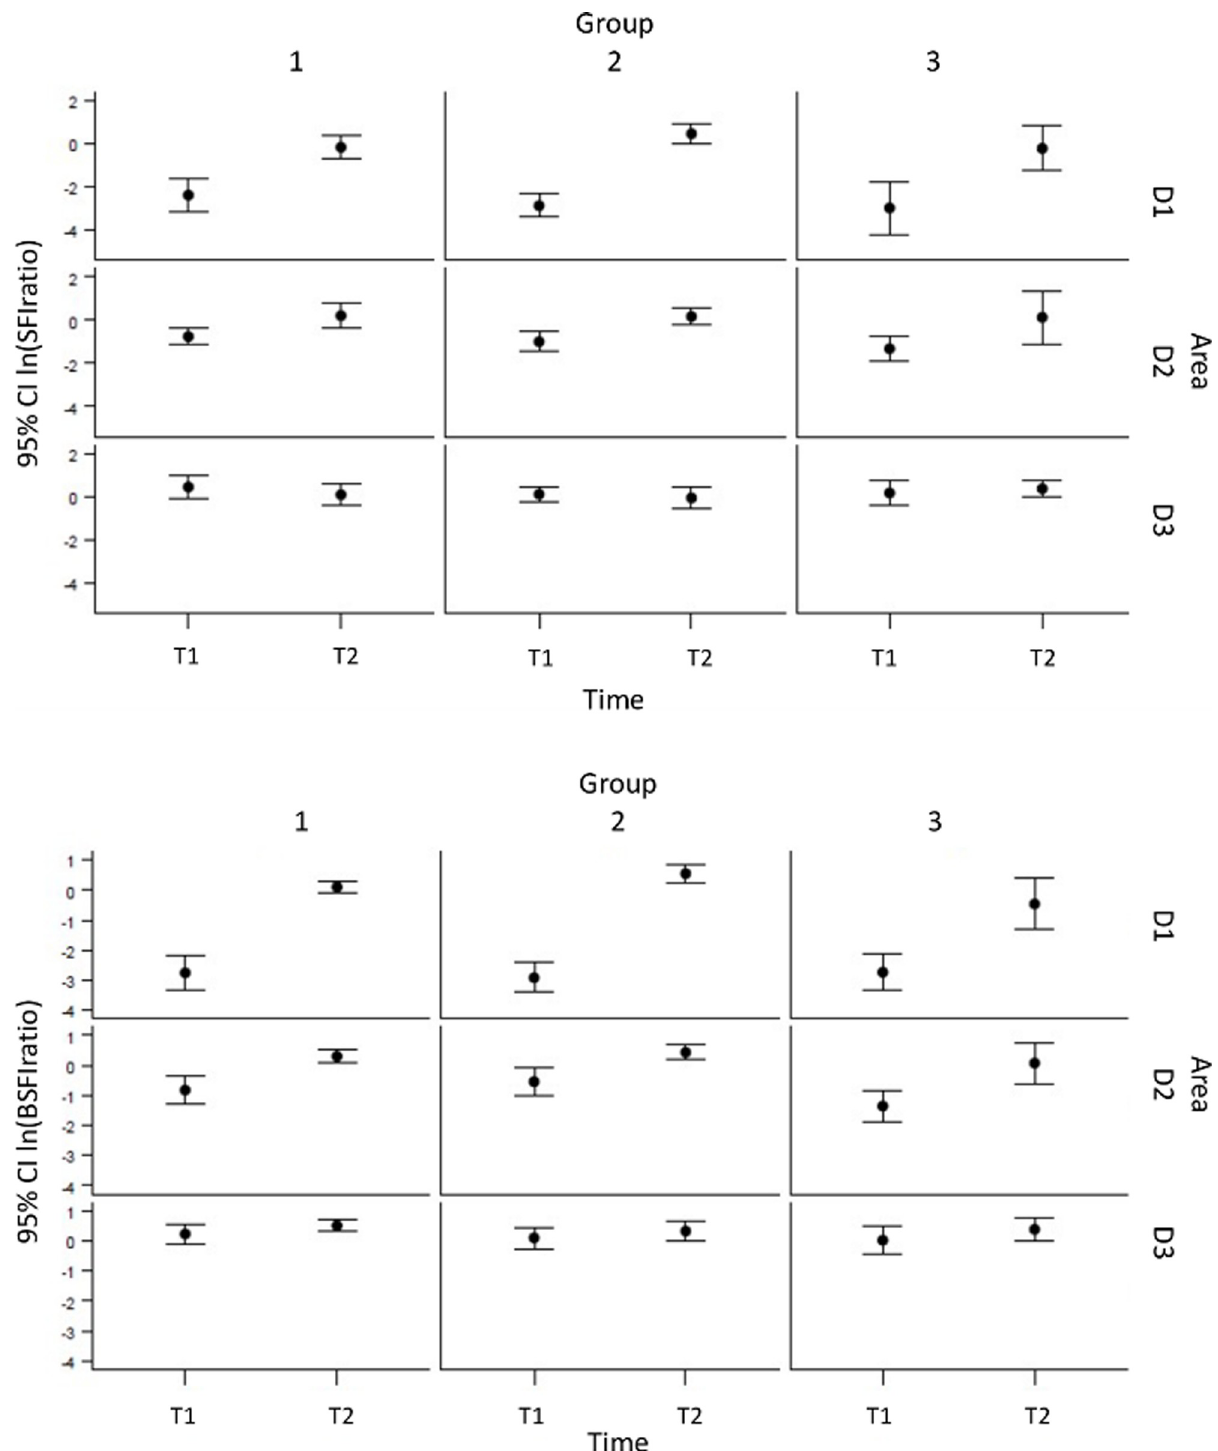
Fig 6. a. SFI–Ratio. Under occlusion SFI ratio reflected perfusion deficit in D1 in the different groups. D2 showed impaired perfusion in all groups, while D3 showed hyper intensity. After reperfusion perfusion areal D 1 showed moderate hyper intensity in group I, while group 2 showed more than doubled values. Interestingly Group 3 had similar results to group I with moderate hyper intensity. D2 and D3 showed hyper intensity after reperfusion in each group. P-values for fixed effects were significant for area (pa), time (pt), and time dependent area (pa � t). The graph shows means and 95% confidence intervals of ln-transformed data by area and time. b. BSFI–Ratio. Perfusion deficit in D1 is well demonstrated, D2 showed reduced ICG-FI